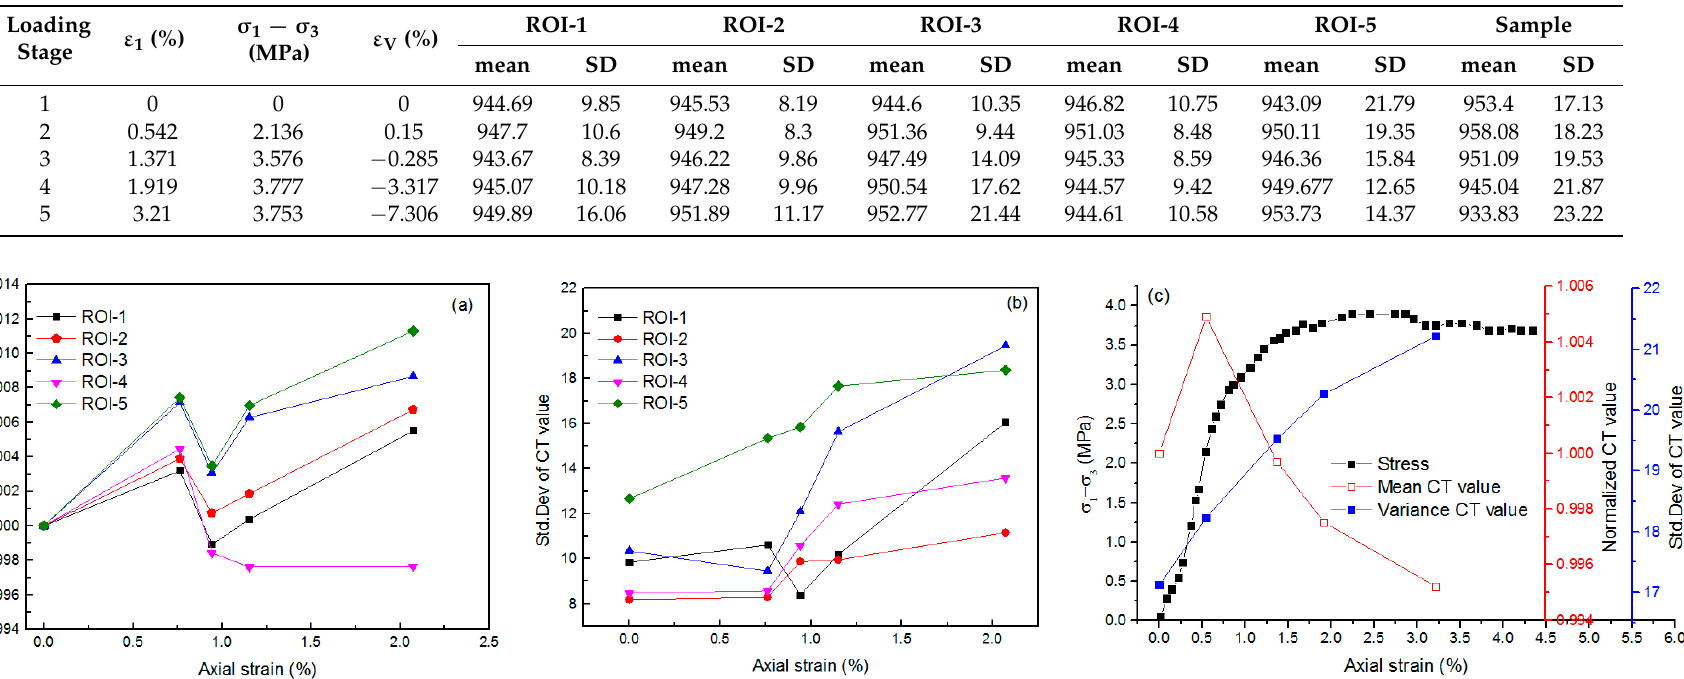
Table 2. The mean and standard deviation of CT values for different region of interest (ROI) in the entire sample. Loading Stage